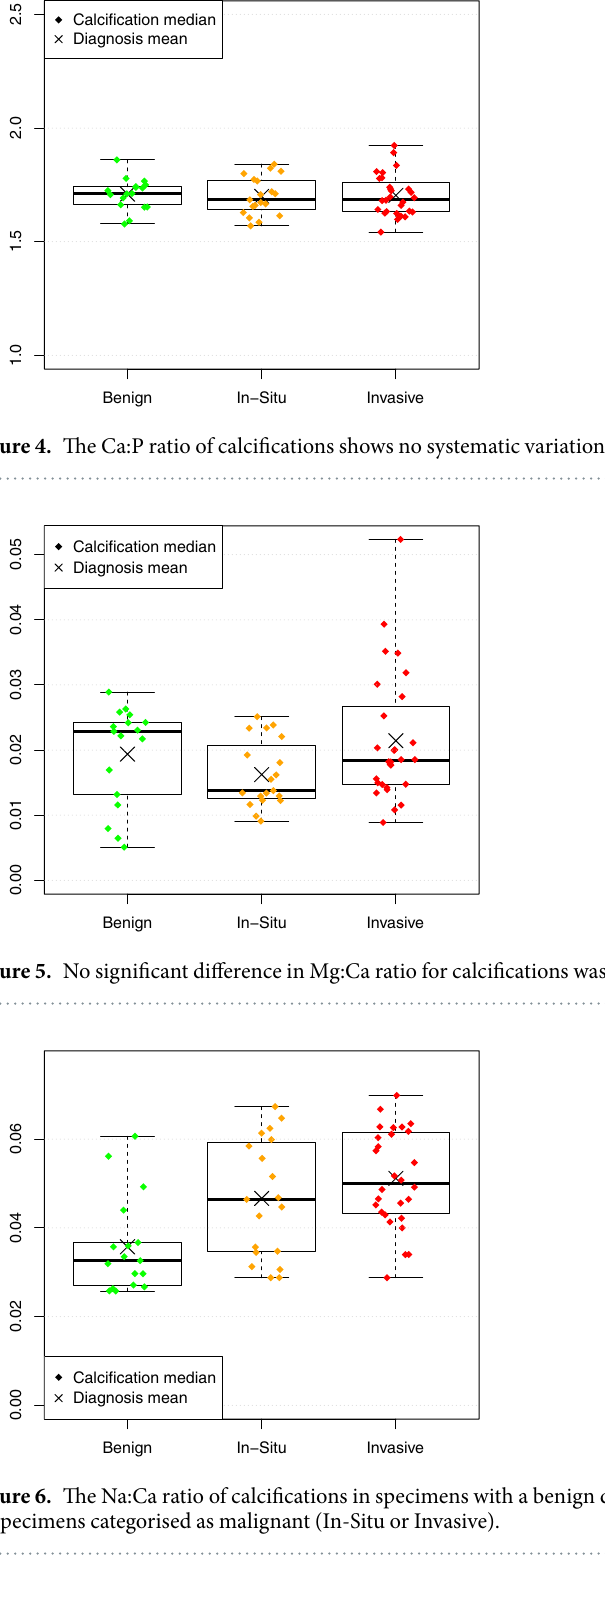
useful information from mammography using energy discriminating detectors. However, the measured Ca:P ratio of calcifications found to lie in a narrow range (interquartile range 1.64 to 1.75), and no significant dif- ference could be found between the pathology groups. These results do not preclude the possibility that some